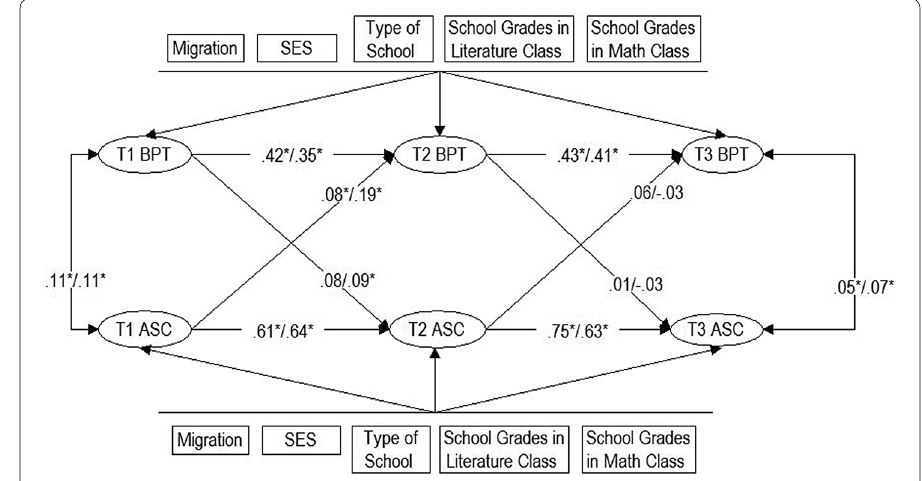
Fig. 1 Study 1: Model scheme of the structure equation model with cross-lags outlined over the measurement points T1 Time 1, T2 Time 2 and T3 Time 3. Girls’ (before the slash)/boys’ (after the slash). = = = ASC academic self-concept (Quellenberg 2009) and BPT belief about one’s own perspective-taking (Davis = = 1980) were specified as latent variables (indicators and residuals are not depicted, see the Additional file 1 for the statistical model). Covariates were included as manifest variables, i.e., migration ethnic background = (out of Germany coded as 1, German background coded as 0), SES socio-economic status, type of school, = school grades in literature class, and school grades in math class. See Table 2 for the path coefficients and standard errors. *p <